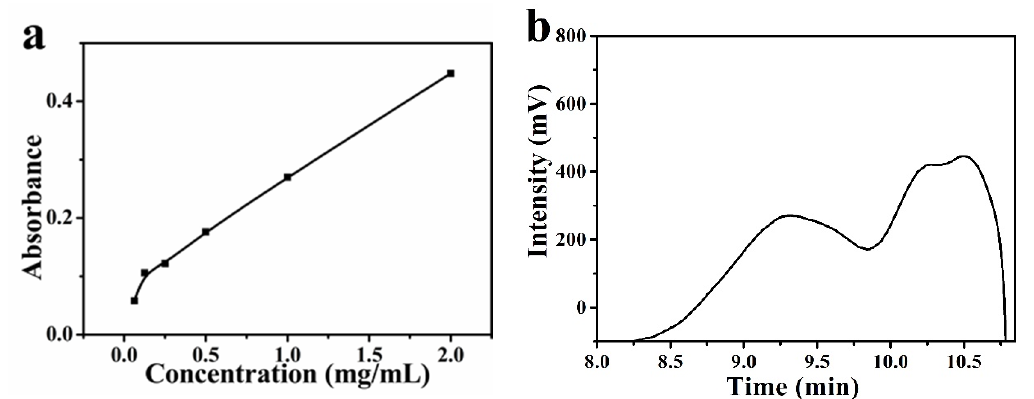
Figure 1. ( a ) The reducing power of BGP and ( b ) GPC elution curve of BGP.